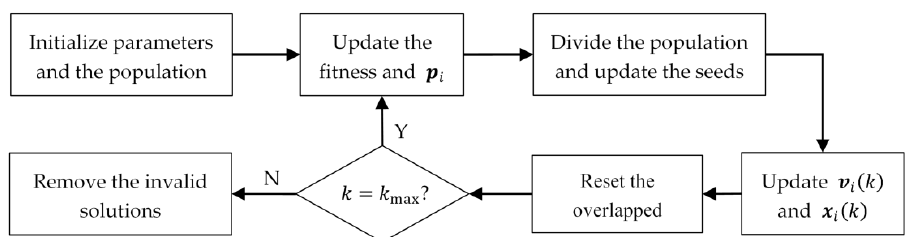
Figure 2. Flow chart of the blind-speed sidelobes (BSSL)-learning-based multimodal optimization (BMMO) method.